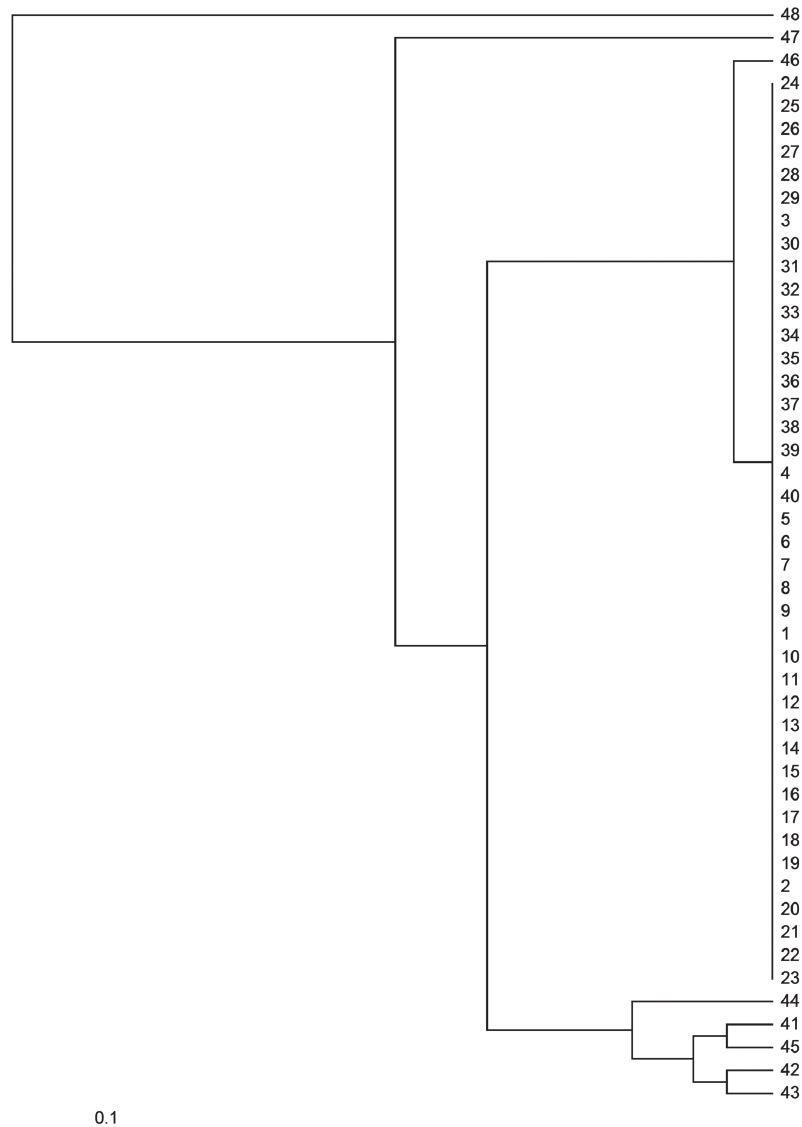
Figure 1 - UPGMA phenetic tree obtained using data from the SSR markers, showing the genetic relationships among the 48 of jatropha accessions, identified according to Table